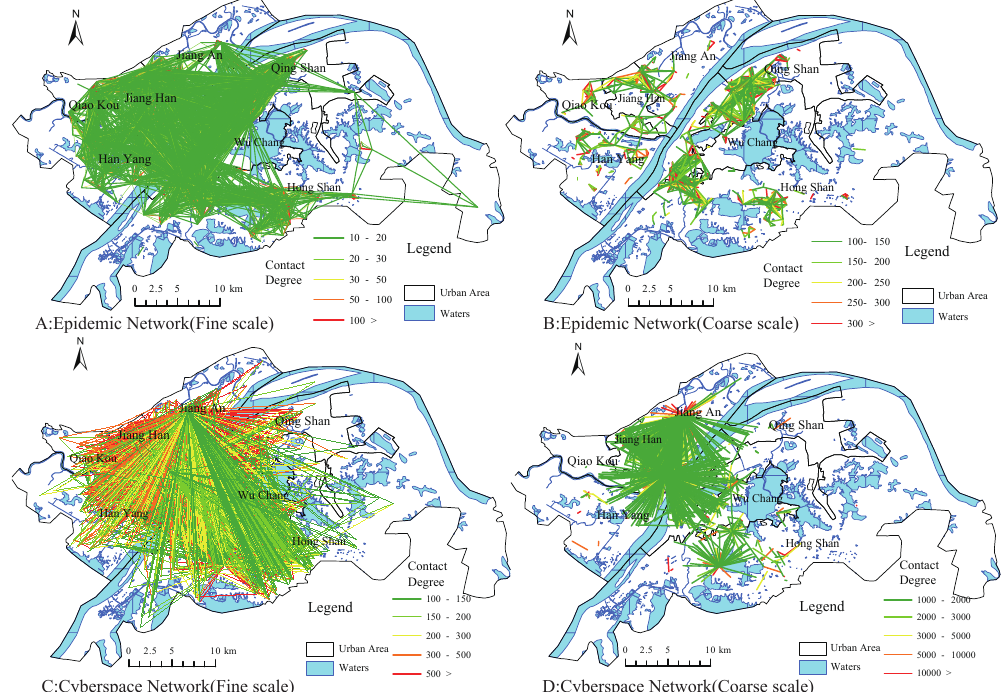
Figure 7. The interactive structure of network reality space in